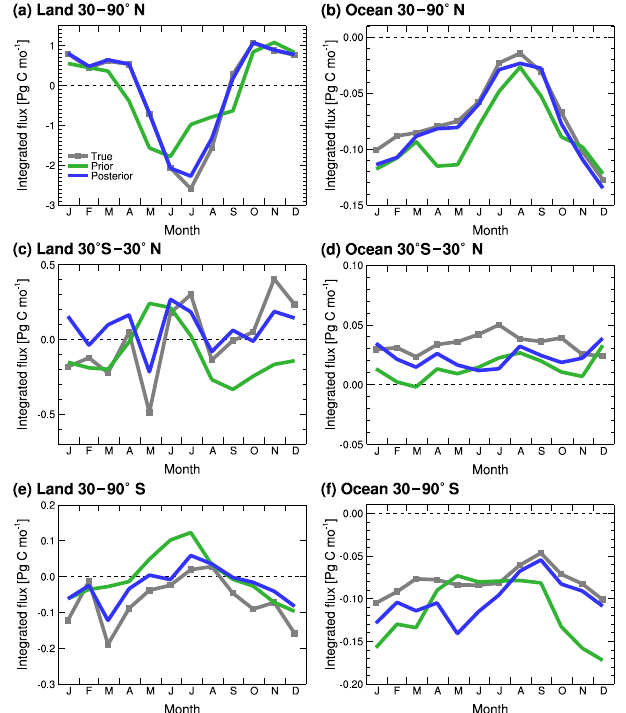
Figure 9. Monthly variations of the true (gray), prior (green), and posterior (blue) CO 2 fluxes integrated for latitude bands of 30– 90 ◦ N (a, b) , 30 ◦ S–30 ◦ N (c, d) , and 30–90 ◦ S (e, f) . Terrestrial (non-fossil fuel flux) (right) and ocean (left) fluxes are separately